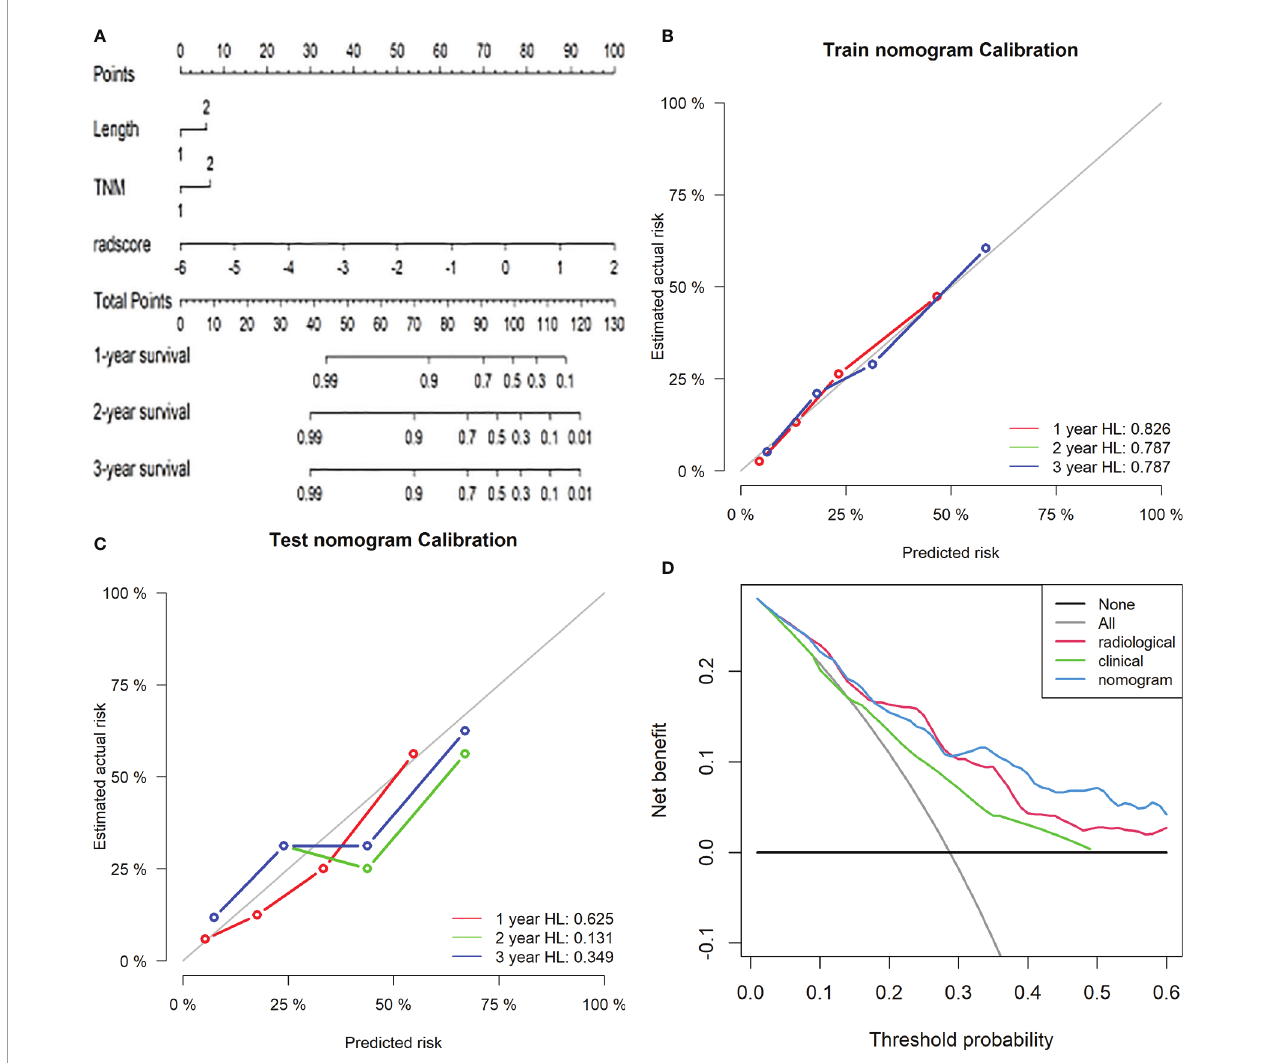
FIGURE 5 | Radiomics nomogram for predicting LRFS of ESCC patients after radiotherapy. Length: 1, length of the oesophageal lesion ≤ 5 cm; 2, length of lesion >5 cm. TNM: 1, clinical stage I-III of oesophageal cancer; 2, clinical stage IV (A) . Calibration curves of the radiomics nomogram in the training (B) and validation (C) cohorts. Potential incremental values of the radiomics nomogram relative to the radiological label were evaluated by net reclassi fi cation improvement (NRI) (D) .